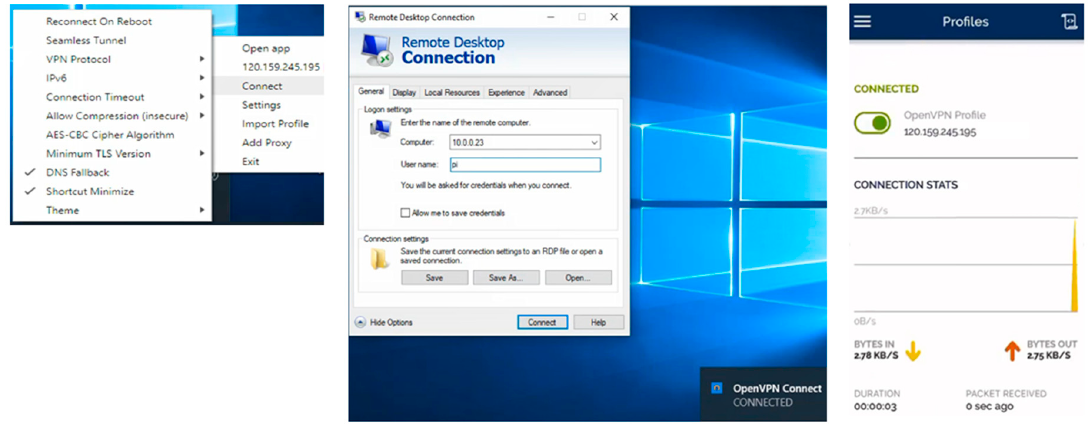
Figure 4. User-interface for the authenticated open VPN connection.